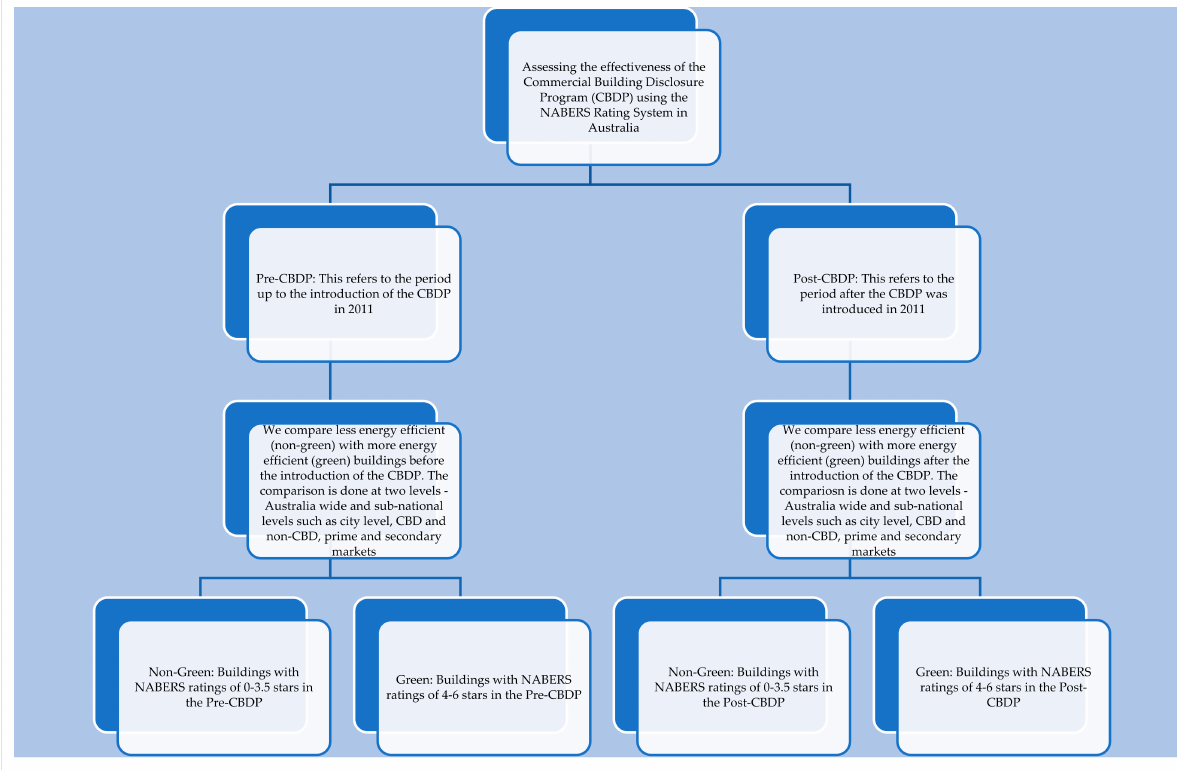
Figure 1. Demonstration of the analysis of the effectiveness of the